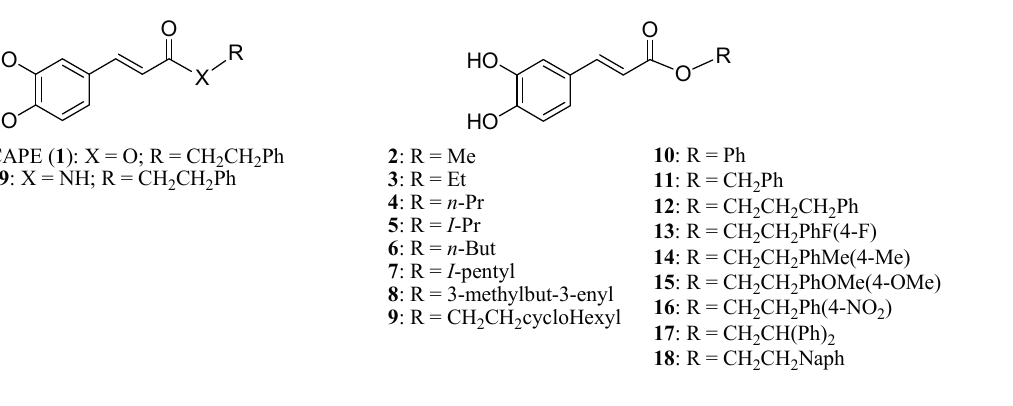
Figure 1. Caffeic Acid Phenethyl Ester (CAPE) derivatives.